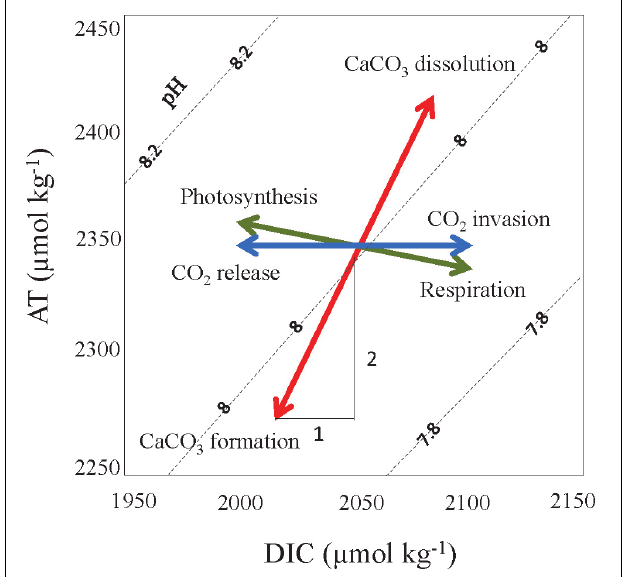
FIGURE 3 | Effect of various processes driving the variability of dissolved inorganic carbon (DIC) and total alkalinity (AT), such as the photosynthesis/respiration (green arrow, DIC decrease/increase and a small AT increase/decrease); calcium carbonate formation/dissolution (red arrow, DIC reduces/increase by one and AT by two units); CO 2 invasion from atmosphere (blue arrow) increases DIC, and release of CO 2 to the atmosphere decreases DIC and AT stays constant in both cases. The dashed lines represent pH as a function of DIC and AT. The figure is adapted from Zeebe and Wolf-Gladrow